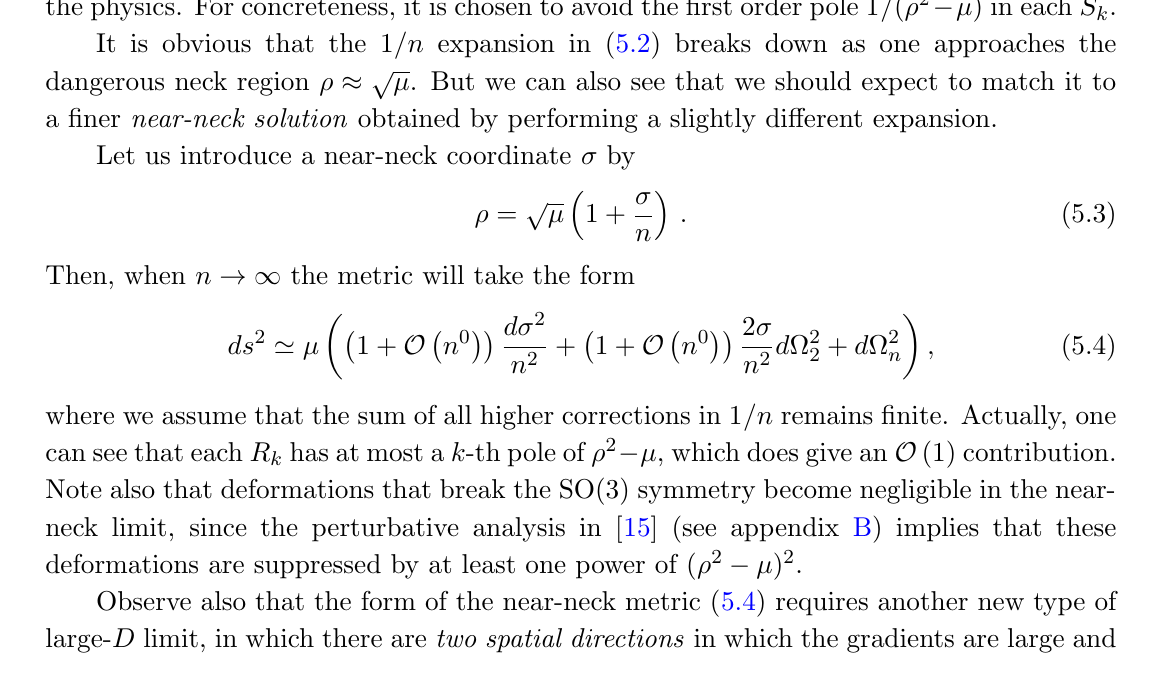
JHEP07(2019)094